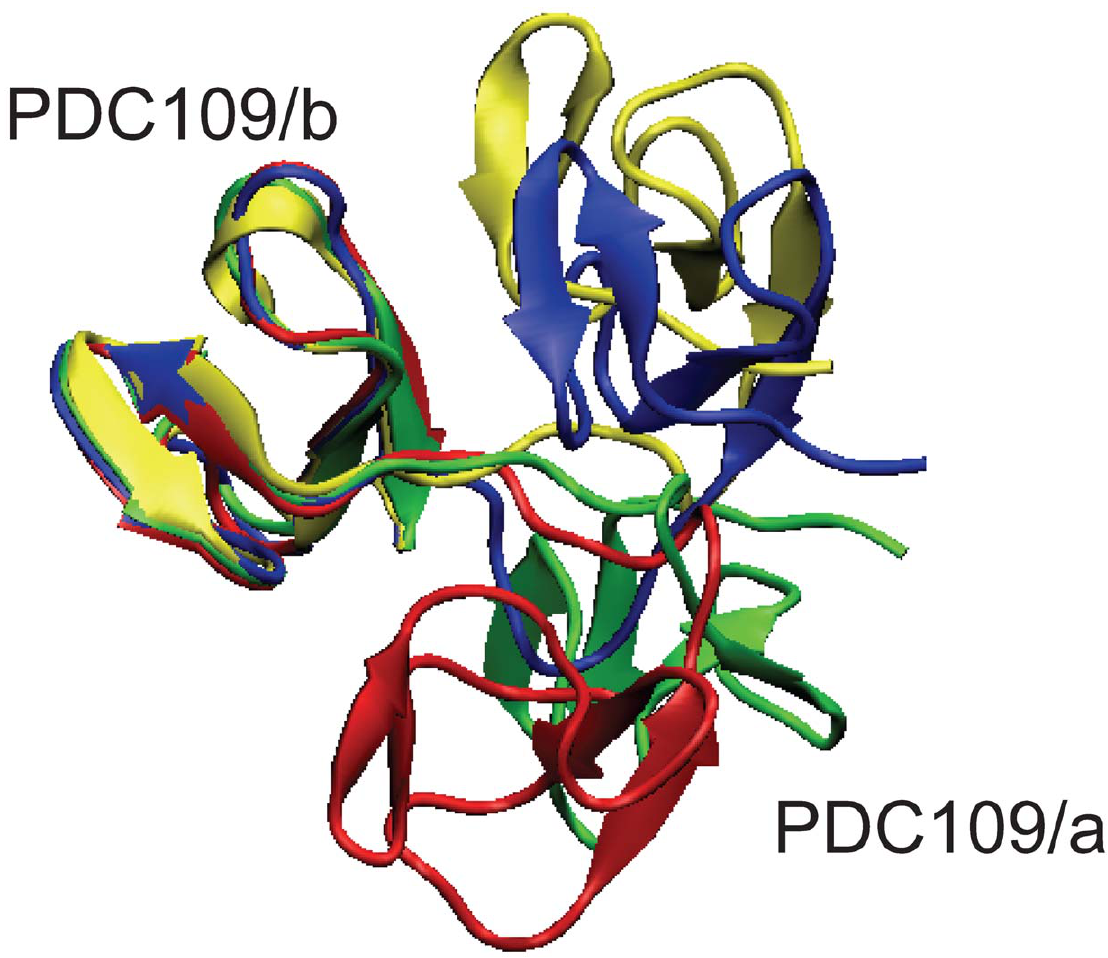
Figure 8. Snapshots of PDC109 during the MD simulations. Structures of the PDC109-PhC complex at 200 ns (red) and 350 ns (blue) and of ligand-free PDC109 at 350 ns (green) are compared against the X-ray crystallographic structure (yellow) via a best-fit of PDC109/b [74].